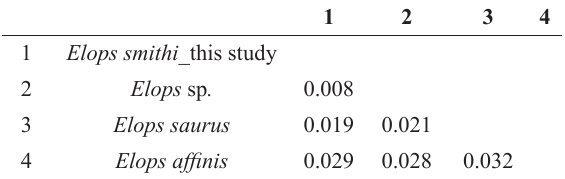
Summary of the pairwise sequence divergence (K2P percentage), based on Cytb gene, between Elops